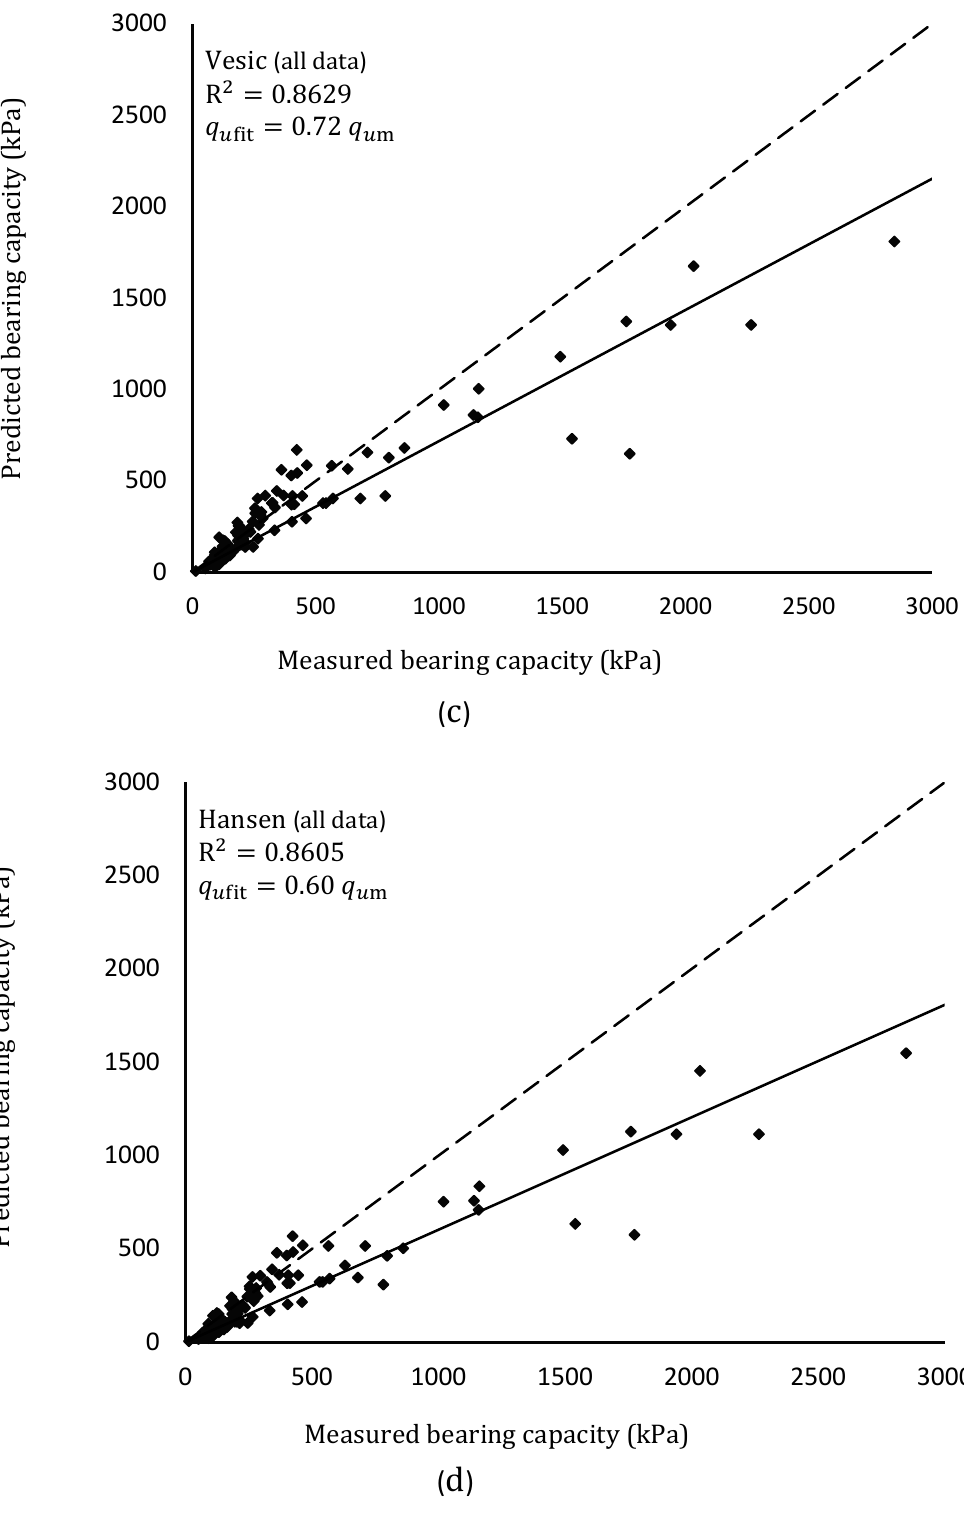
Fig. 5. Measured versus predicted capacity for (solid line and dashed line indicate best fit and perfect fit lines, respectively): a) RF model; b) Meyerhof; c) Vesic; d)